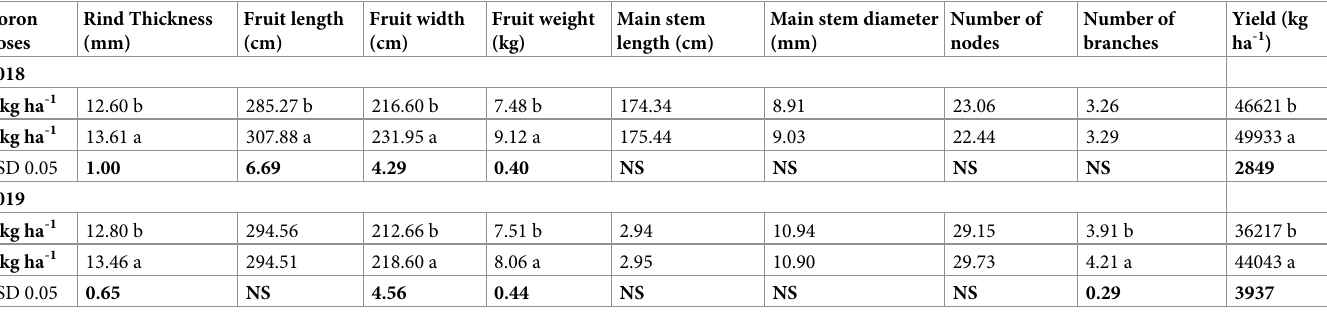
NS NS NS 0.29 3937 Means followed by similar letters within a column are statistically non-significant (p >